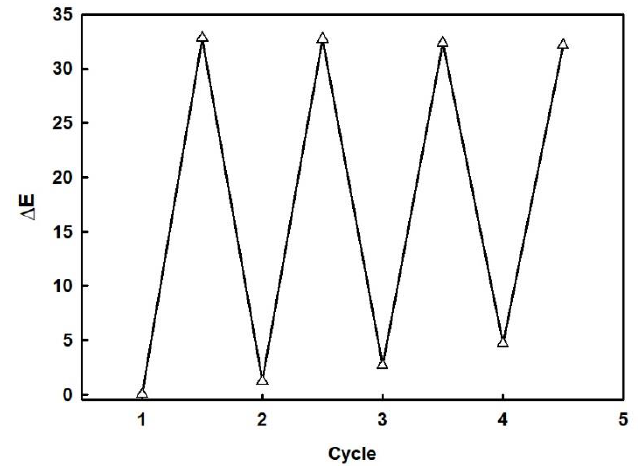
Figure 7. Acidic gas detection cycle of printed textile sensor.